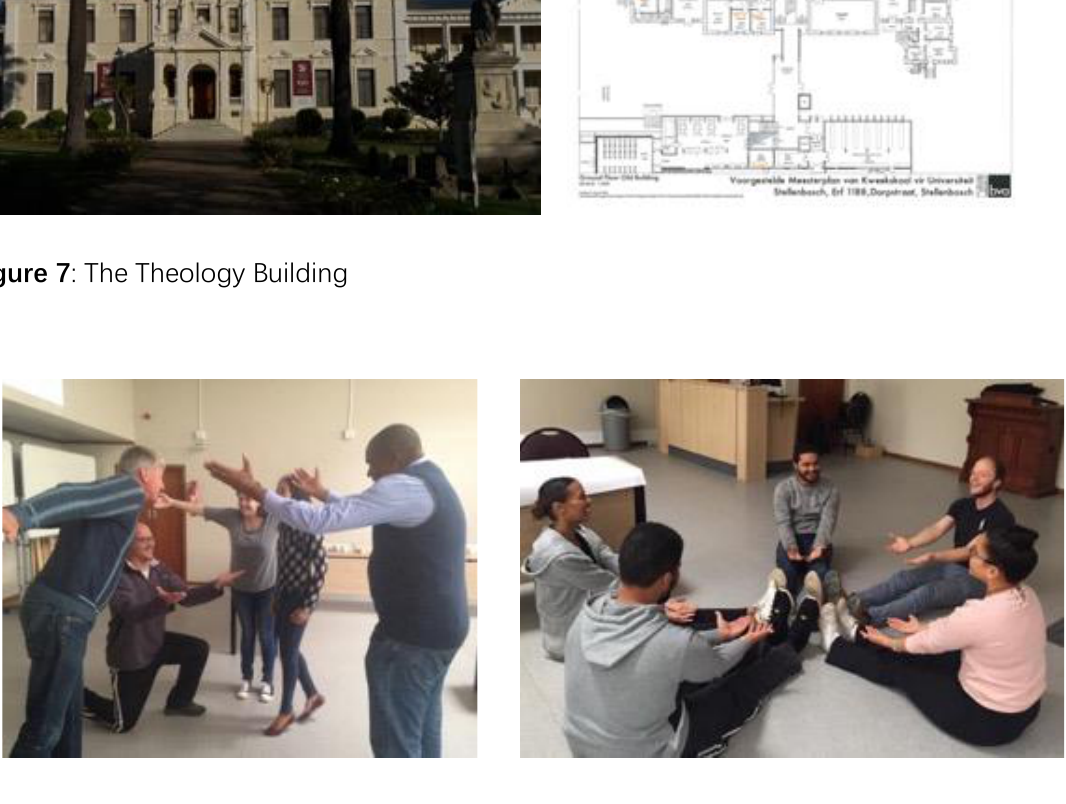
Figure 9 : Imagining an inclusive